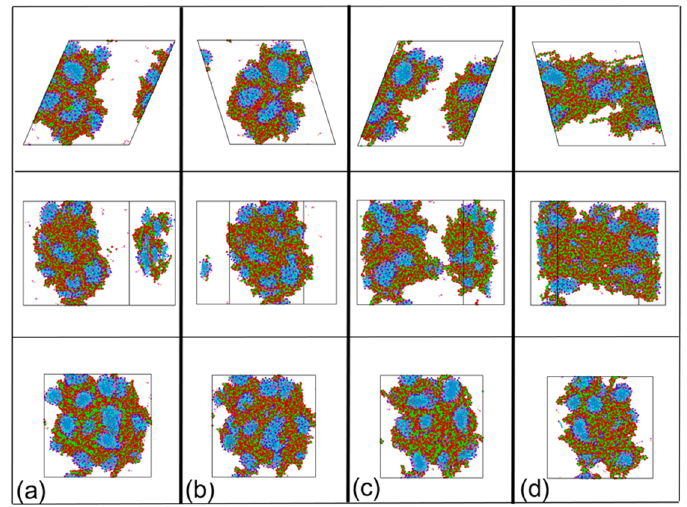
Figure 7. Snapshot of the CTAC based solution when the shear rate is 8.65 × 10 8 s − 1 . ( a ) time: 0.5 ns; ( b ) time: 0.8 ns; ( c ) time: 1.6 ns; ( d ) time: 5.6 ns. Top view: first line, front view: second line, left view: third line. Color scheme: purple, hydrophilic part of CTAC; cyan and blue, hydrophobic tail of CTAC; magenta, aromatic ring of Sal − ; khaki, charge group of Sal − ; red, the acidammide group of PAM; green, carbon backbone of PAM. Na + (yellow), Cl − (dark green), water sites (reddish), and antifreeze water sites (grey) were hidden for clear display.